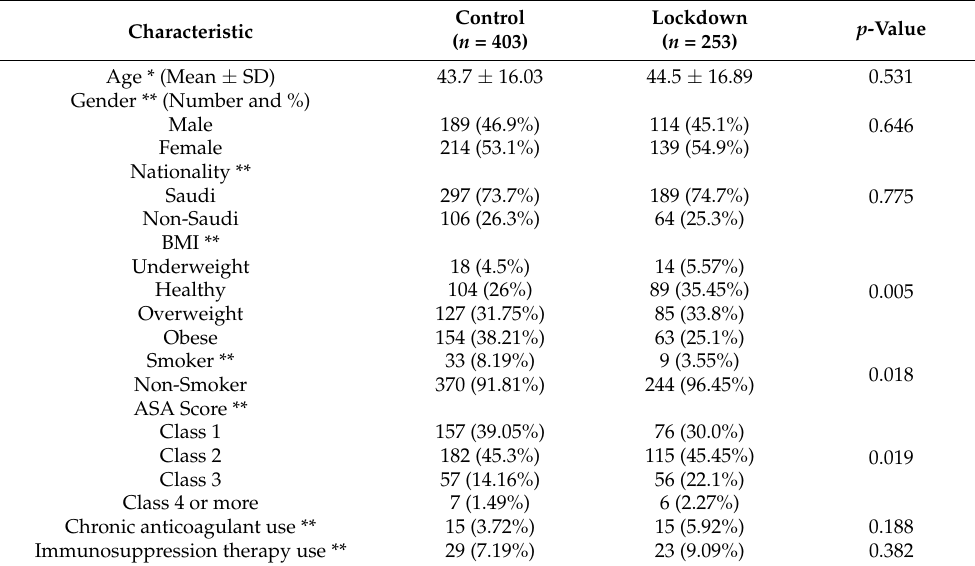
Table 1. Basic demographic characteristics of patients during the pre-COVID (control group) and COVID periods (Lockdown